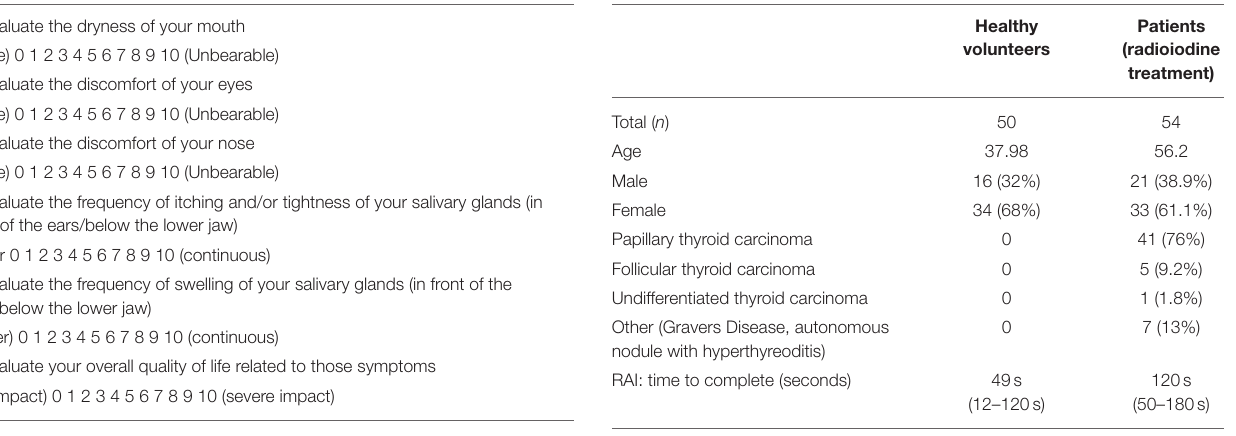
TABLE 1 | RAI-6 questionnaire (0–10 visual analogue scale). TABLE 2 | Participants demographics and time to complete